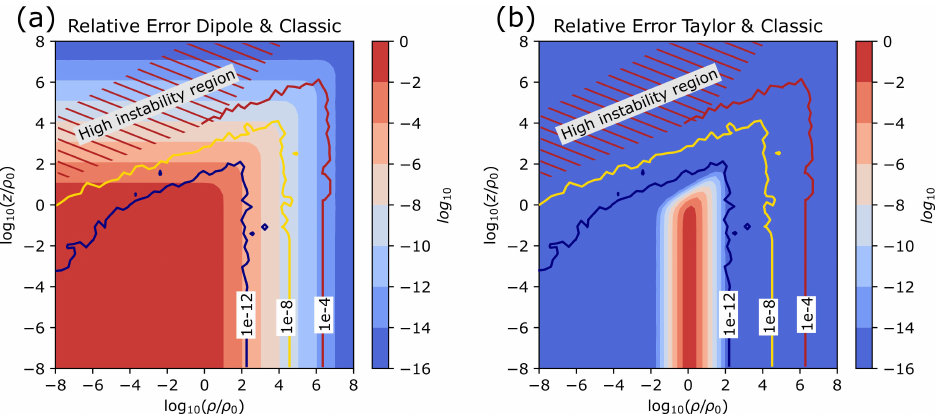
Figure 5. Vectorwise relative error of the dipole approximation ( a ) and a Taylor approximation ( b ) of the B -field of a current loop. The colored contour lines show the numerical error from a straightforward implementation of the classical textbook